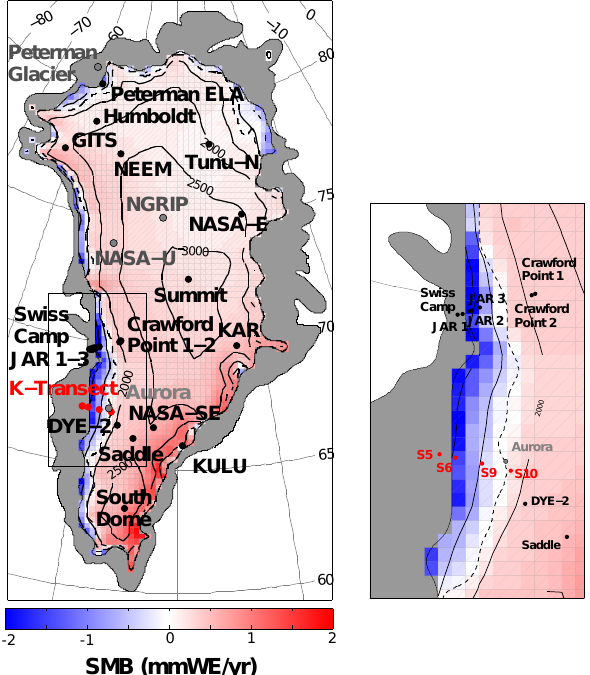
Figure 1. MAR v3.2 mean September 2000–August 2013 SMB (mWEyr − 1 ) and locations of all GC-Net and K-Transect weather stations. Pixels not defined as 100% ice covered in MAR v3.2 are masked out. The dotted black line is the mean equilibrium line (where mean SMB is 0). The K-transect stations (S5, S6, S9, S10) are red, while GC-Net stations are black. Stations in grey are GC- Net stations not used in this study. Other contour lines indicate ele- vation in metres above sea level. The inset shows individual stations near the west coast ablation